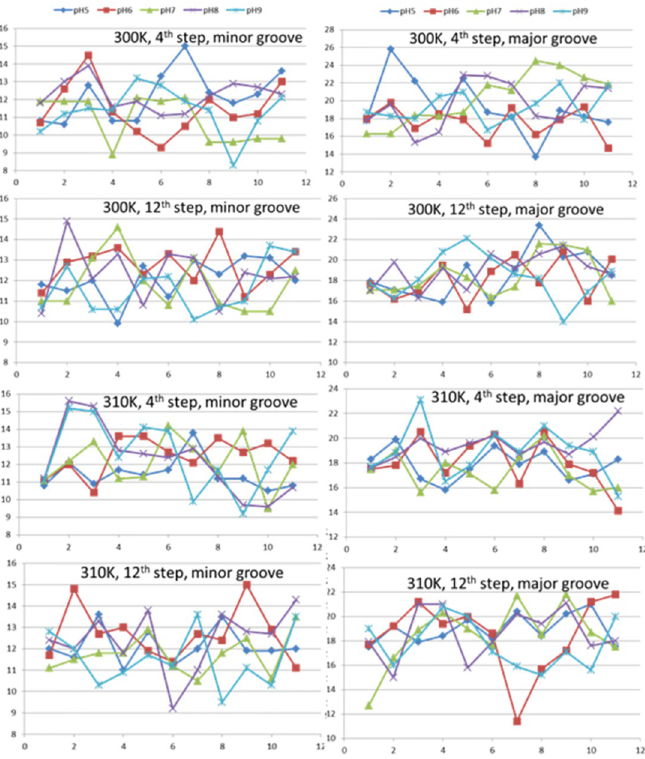
At 310K, the width of minor groove at the 4 th step has less variations within the range 9.6 to A˚´ 15.2 . Larger fluctuations have been observed in the beginning of dynamics in the case of pH 8 & 9 whereas groove widths at pH 7, 6 and 5 have less fluctuations during the entire course of dynamics. However, the minor groove widths have increased after the dynamics, designating increased instability of the DNA junction. Minor groove width at the 12 th step, varies within A˚´ A˚´ the range 9.2 to 15.0 , larger being in the case of pH 6 while smaller values are observed at pH 8. In neutral case minor groove width variation is smaller as compared to variations for other pH values. The major groove widths at 4 th step have smaller fluctuations and reduced at the end of dynamics, except the case of pH 8. Comparatively larger fluctuations have been